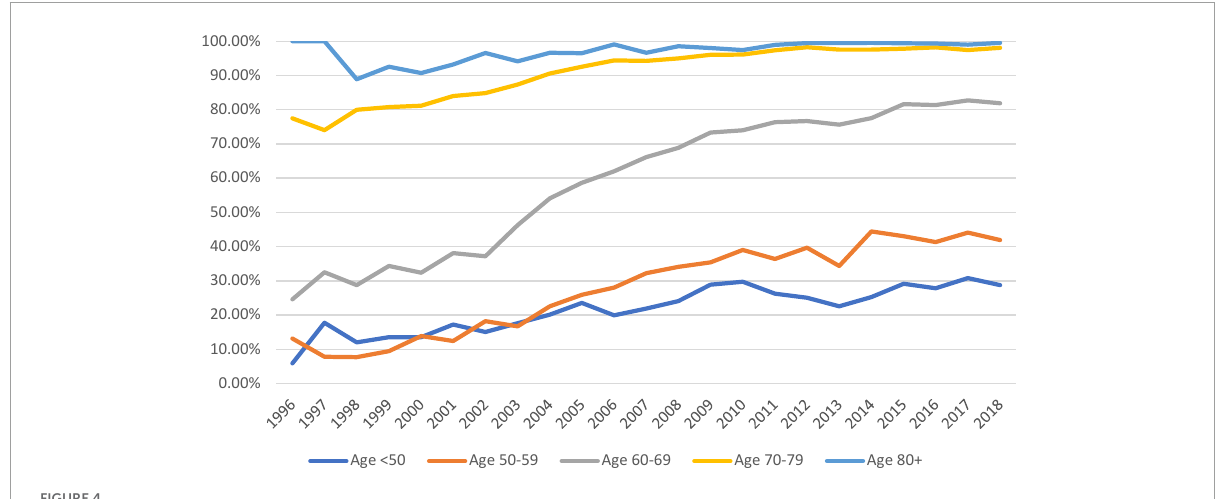
FIGURE4 Trend of the proportion of bioprostheses used (against mechanical prostheses) across all five age groups from 1996 to 2018 (dark blue: < 50, orange: 50–59, gray: 60–69, yellow: 70–79, and pale blue: > 80).